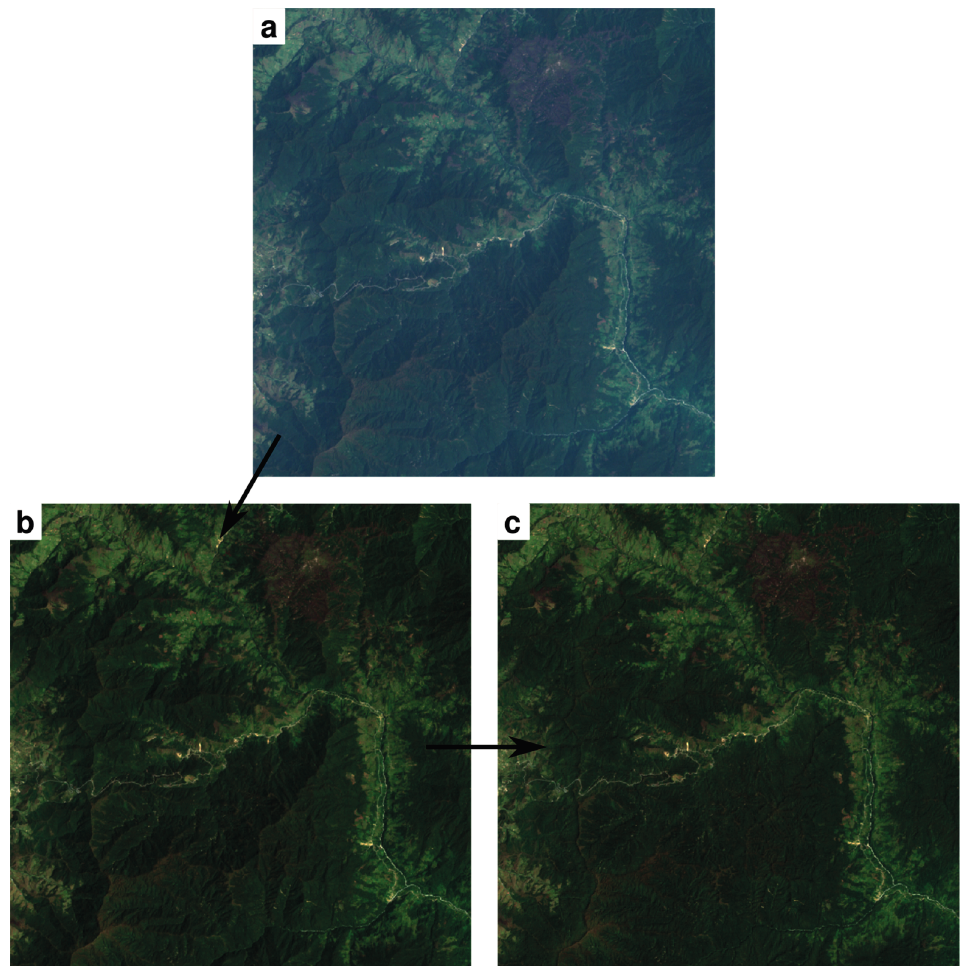
Figure 5. RGB color composites of the Landsat ETM+ scene of 2001 with different processing levels: ( a ) no processing; ( b ) atmospherically corrected with the modified version of the 6S code; and ( c ) atmospherically corrected with the modified 6S code plus the semi-empirical topographic